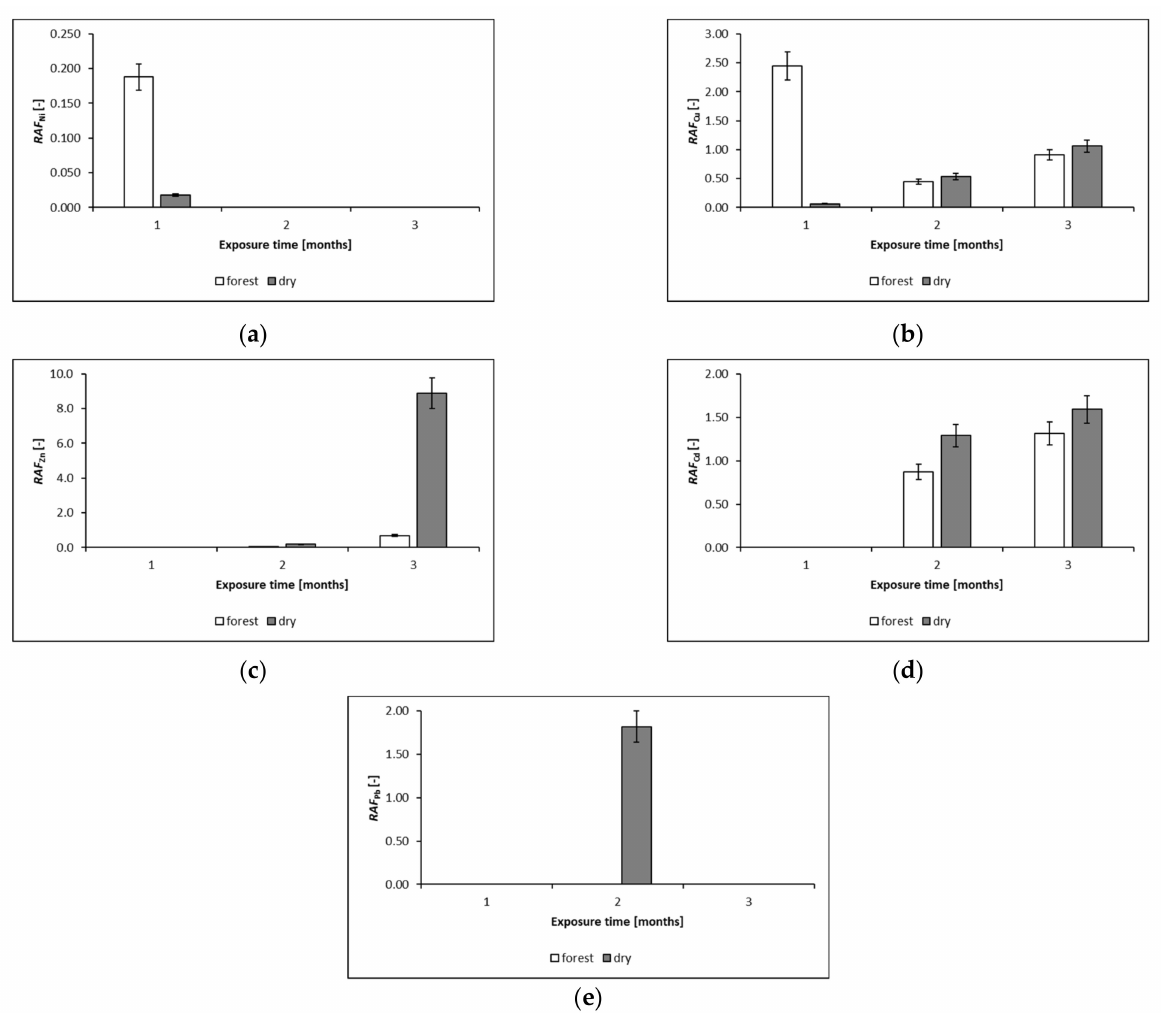
Figure 3. RAF values for: ( a ) nickel-, ( b ) copper-, ( c ) zinc-, ( d ) cadmium-, and ( e ) lead-exposed forest (fresh) and dried mosses. RAF—Relative Accumulation Factors (meaning and formula are given in Section